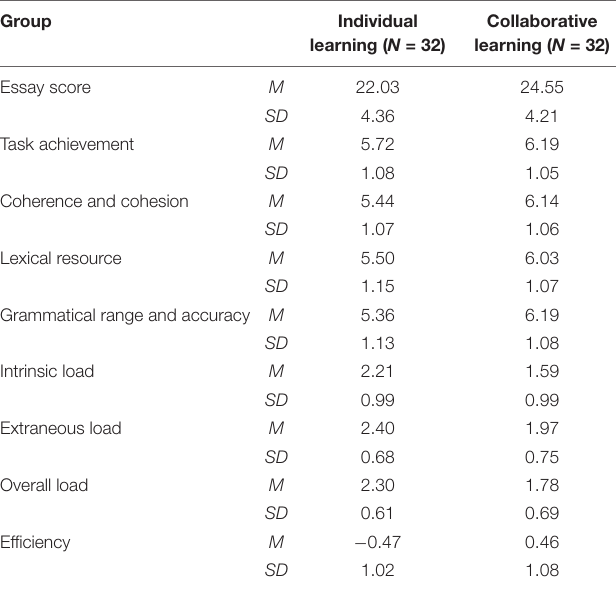
TABLE 1 | Means and standard deviations for essay writing performance scores, individual category score, subjective ratings of cognitive load, and instructional efficiency for two instructional